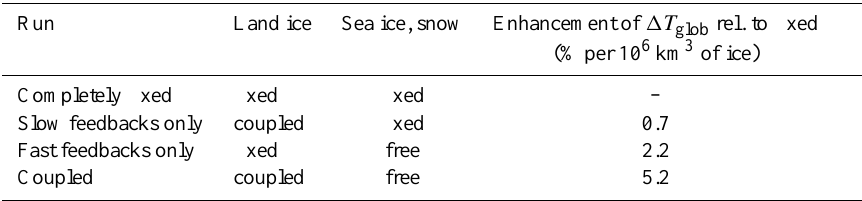
Table 4. Overview of the enhancement of global temperature anomalies induced by coupling the land ice and/or freely calculating sea ice and snow cover in the ZEBCM, relative to the completely fixed run where PD values are